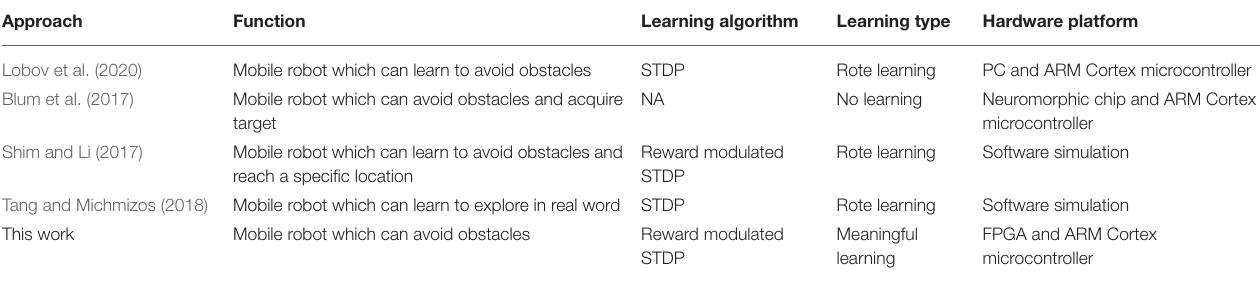
TABLE 4 | Comparisons with previous